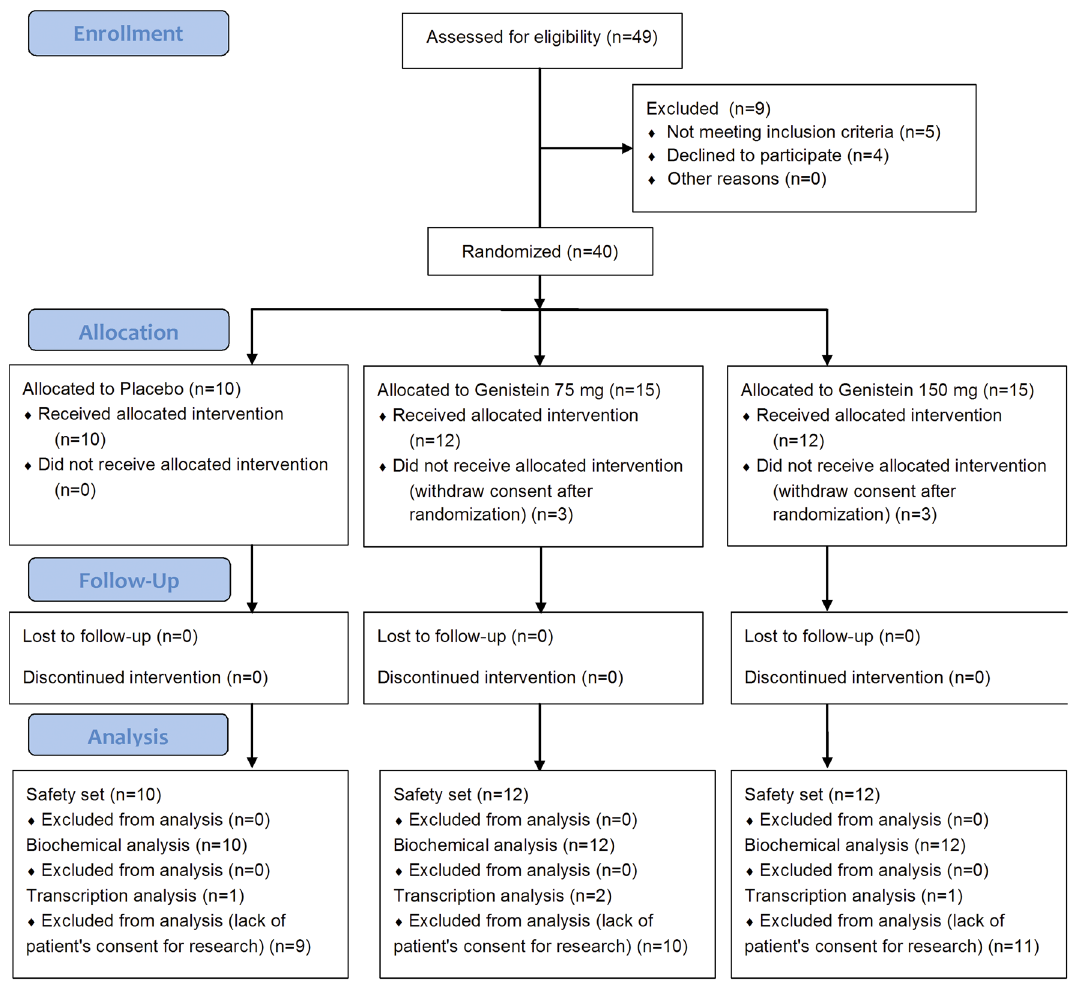
Figure 7. Overview of in vivo study related to the clinical trial reported in 16